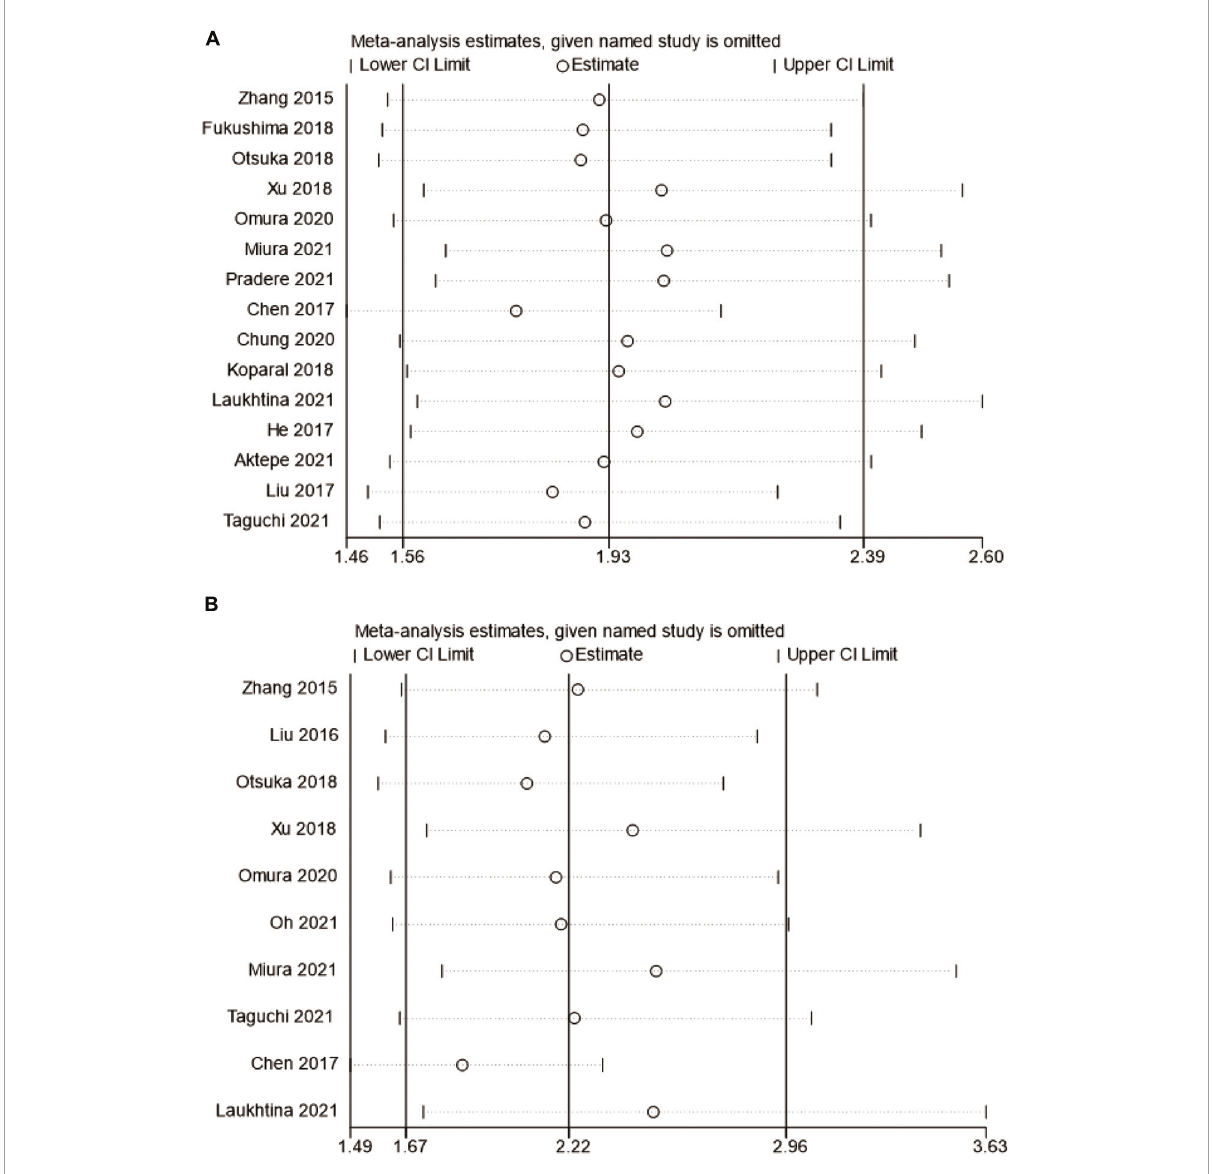
FIGURE8 Forest plot for sensitivity analysis. (A) overall survival and (B) cancer-specific